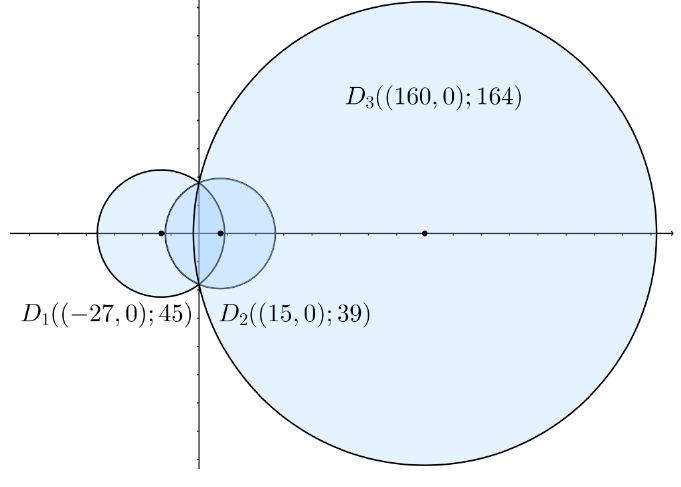
Figure 6. The 2-disk system M